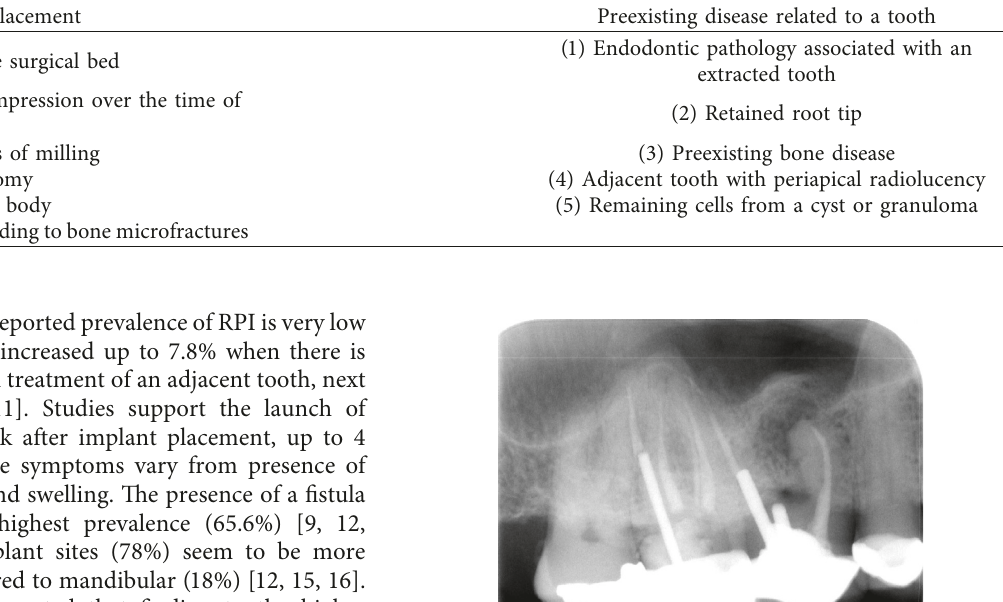
Table 1: Etiological factors of RPI.